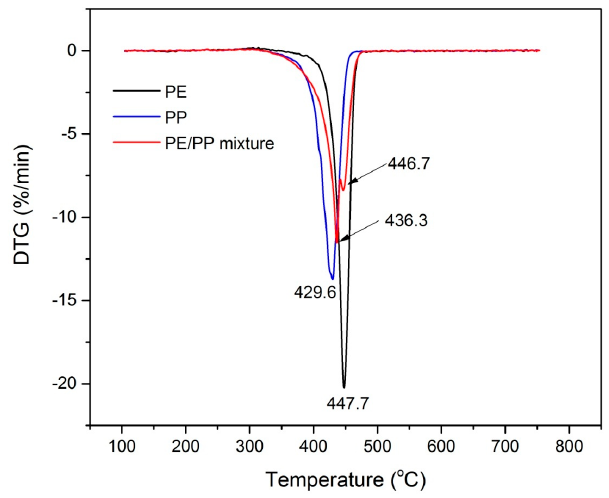
Figure 2. Derivative thermogravimetric analysis (DTG) curves of PE, PP and PE/PP mixture. Table 1. Elemental analysis of plastic feedstock (results expressed in ppm). PE: polyethylene; PP: polypropylene; n.d.: not